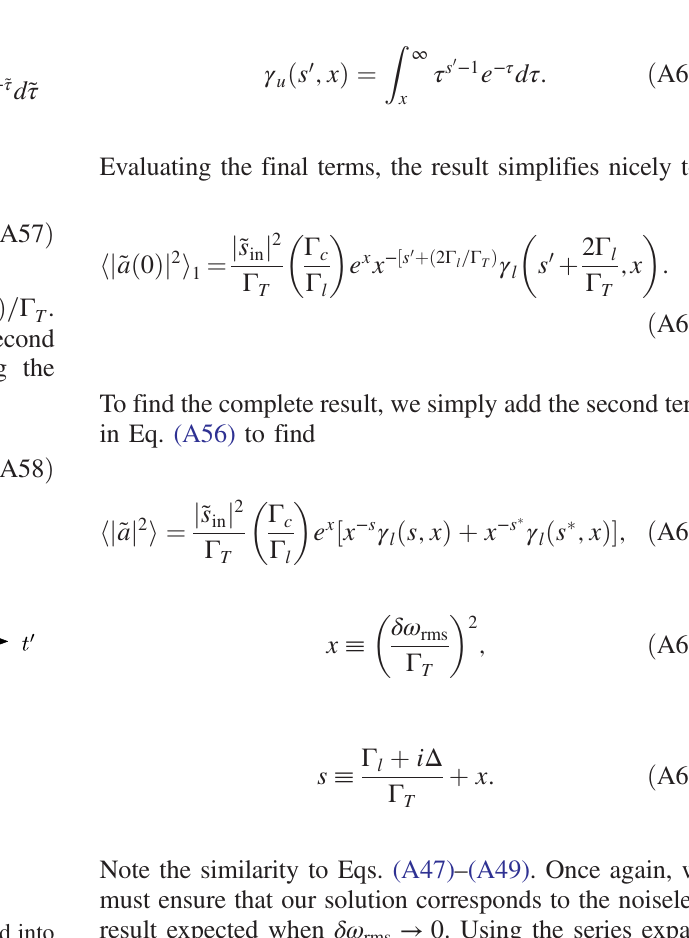
FIG. 8. The complete region of integration can be divided into three subspaces which yield different conditions for k ð t Þ